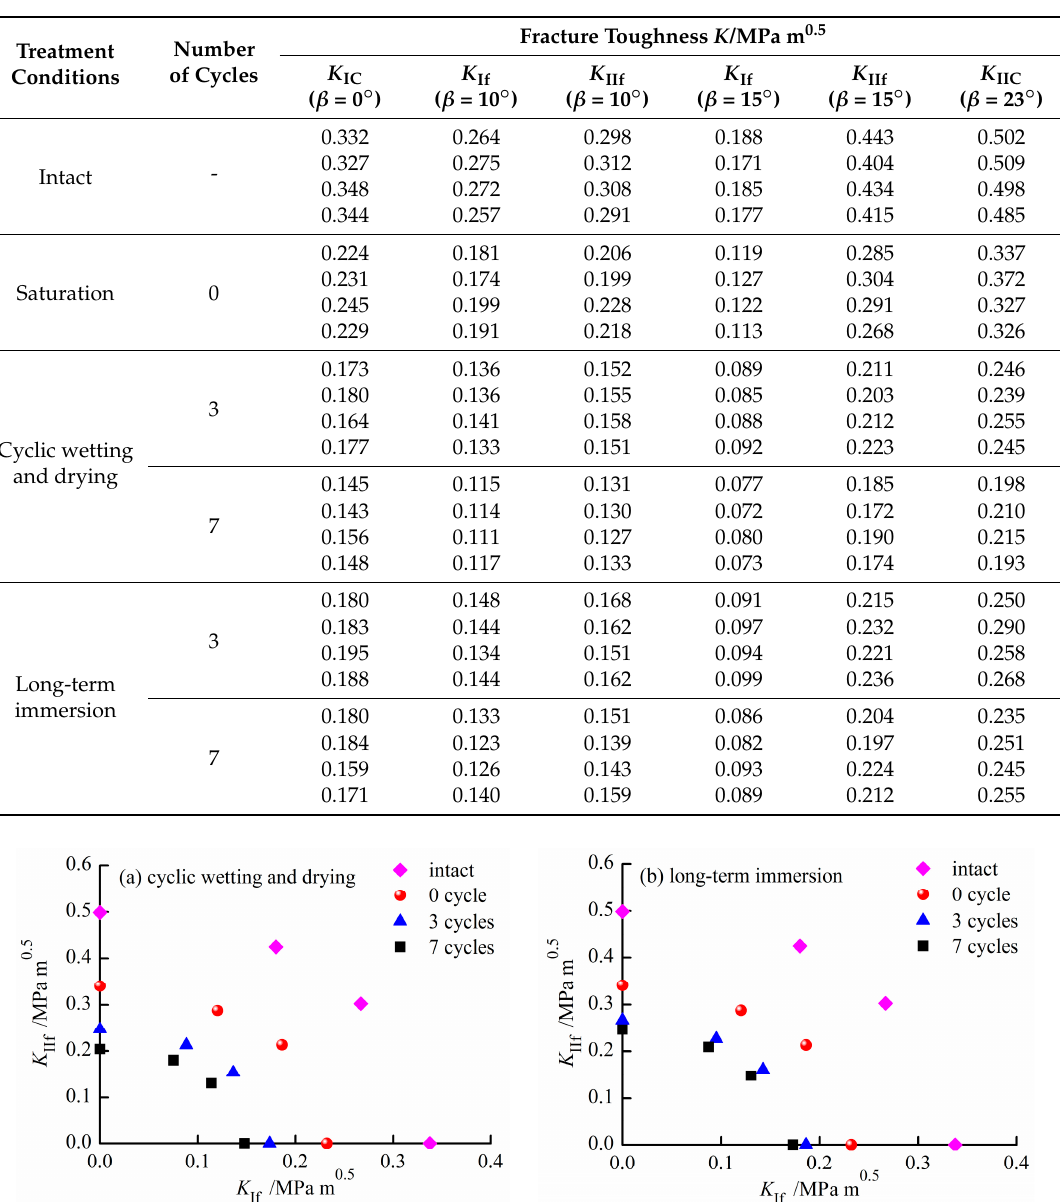
Table 1. Test values of fracture toughness for sandstone under different water–rock interaction conditions.